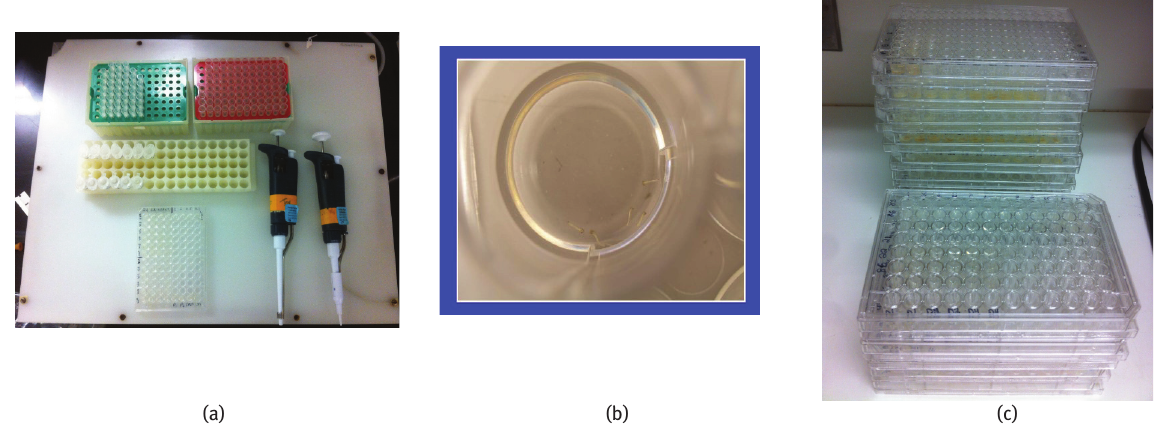
Figure 2: Larval bioassay against 1 st instar Ae. aegypti , a) preparing samples to assay; b) each well contains 5 larvae; c) After treatments, samples were kept in 96-well plates were kept at room